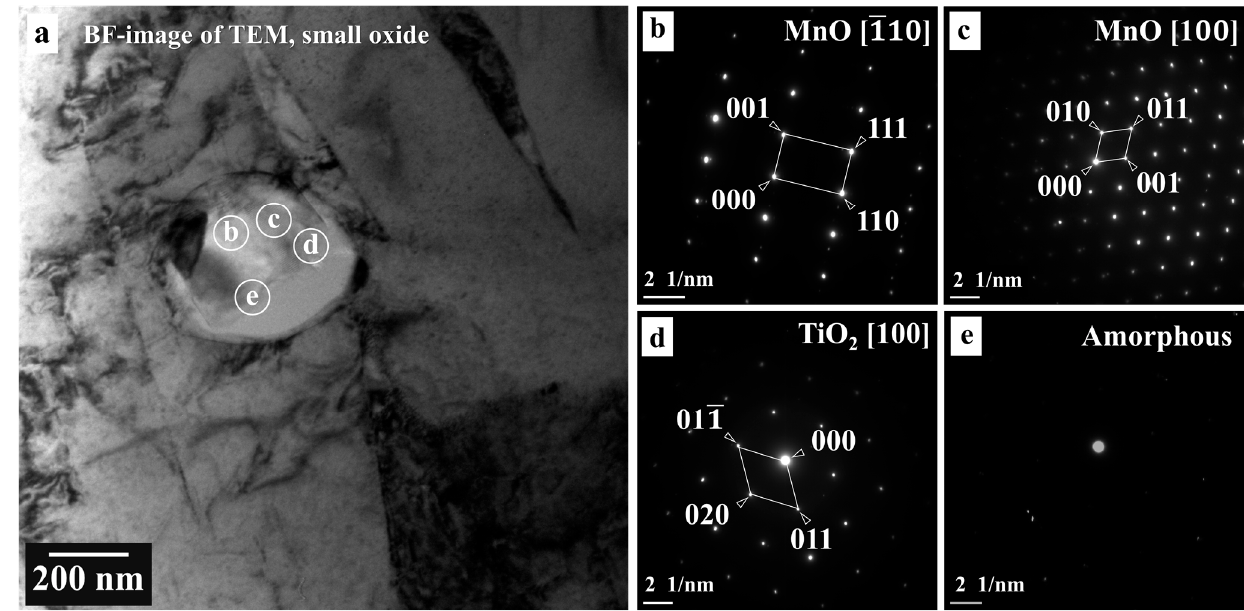
Figure 3. TEM images corresponding to small oxide inclusions: ( a ) BF-image with selected areas for diffraction patterns; ( b , c ) SADP of MnO; ( d ) SADP of TiO 2 ; ( e ) and SADP of amorphous.